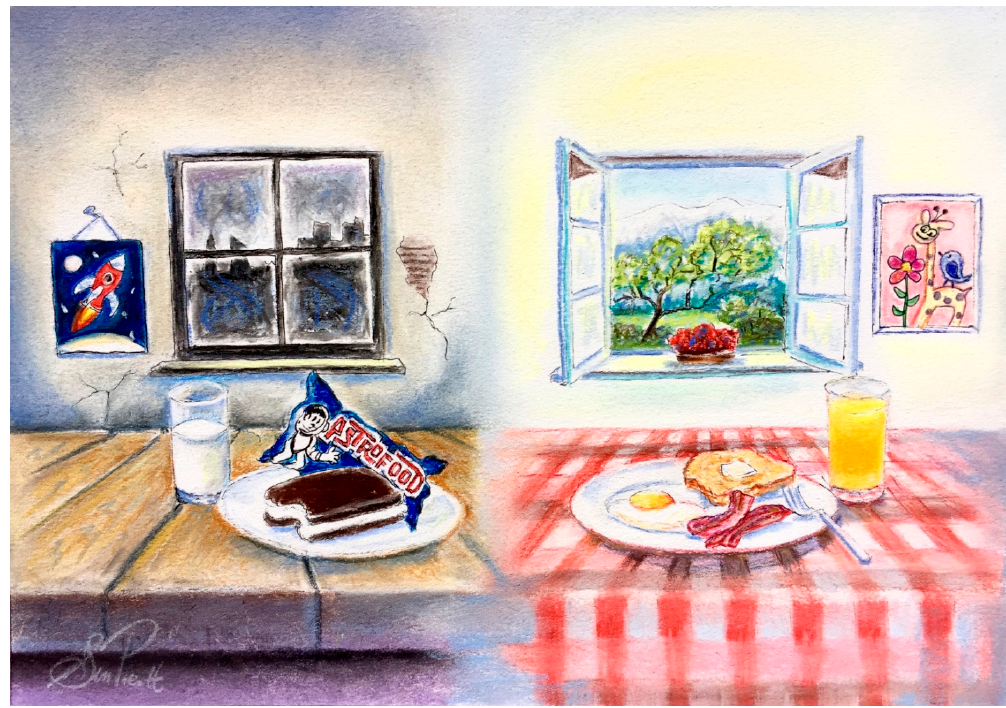
Figure 1. Remediation : In response to gross socioeconomic inequalities, disadvantage and social injustice in the total childhood environment, an ultra-processed breakfast food cake (Astrofood) was engineered and marketed for its “nutritional” equivalency. Its legacy remains in plain sight (Image: Alan C. Logan, Susan L. Prescott).